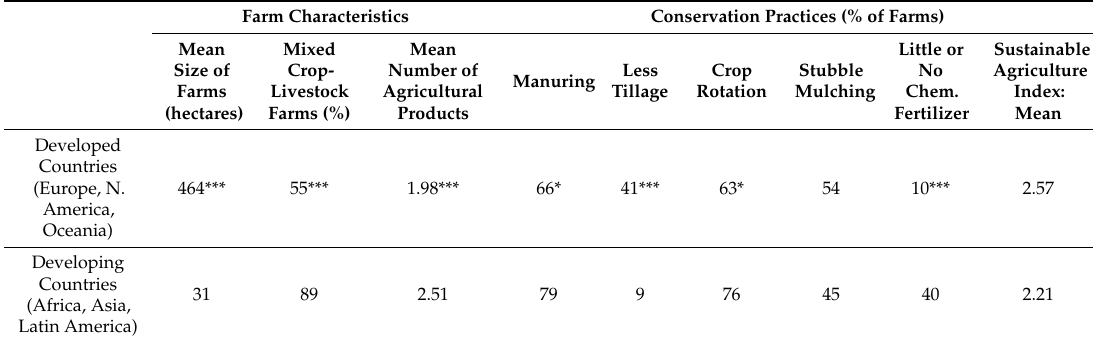
Table 2. Farm characteristics and conservation practices: developed and developing